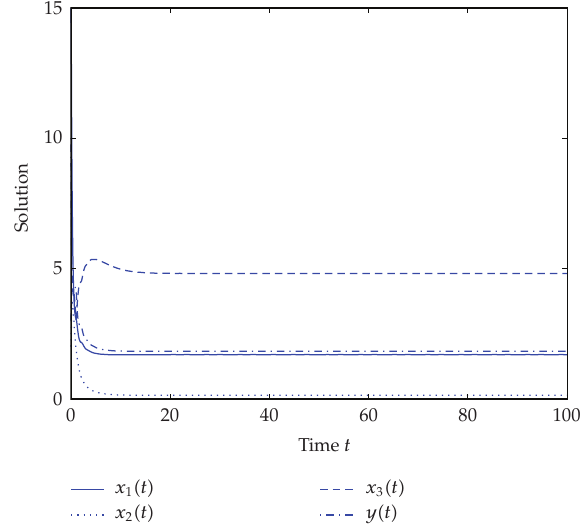
Figure 1: The numerical solution of system (cid:3) 1.4 (cid:4) with α (cid:7) 1 , β (cid:7) 2 , γ (cid:7) 0 . 5 , r 1 (cid:7) 3 , r 2 (cid:7) 1 , r 3 (cid:7) 0 . 5 , r